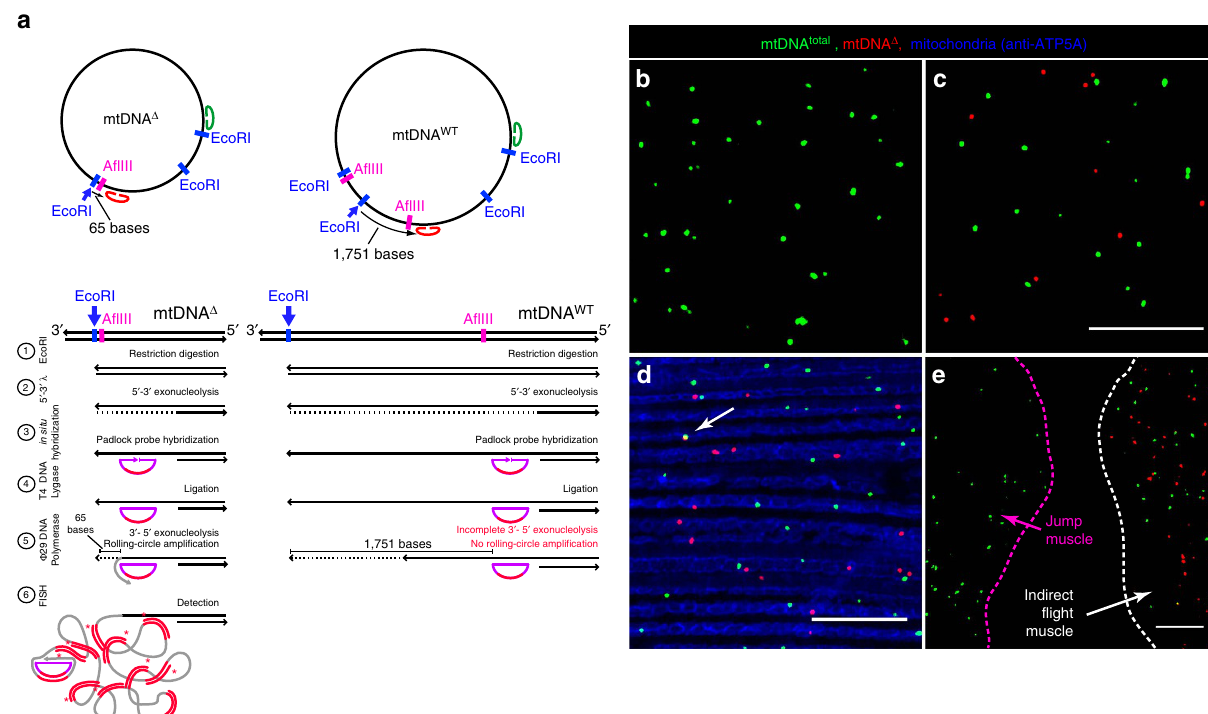
Figure 3 | Rolling circle-based quantification of mtDNA total and mtDNA D . ( a ) Strategy for visualizing mtDNA D and total mtDNA in situ , using padlock probes and target-primed rolling-circle amplification (tpRCA). ( b ) P{ pIFM-Gal4 }attP1 (wild type) IFMs reacted with probes specific for mtDNA D (red) and mtDNA total (green) contain only green dots. ( c – e ) IFMs from P{ pIFM-mitoAflIII, pIFM-mitoT4lig, pIFM-Gal4 }attP1 ( mitoAflIII ) flies contains red and green dots. ( d ) IFMs from mitoAflIII flies stained with anti-ATP5A (blue) show mitochondrial localization of red and green dots. Co-localization between fluorophore-tagged mtDNA D and mtDNA total was seen only rarely (white arrow in d ), reflecting the fact that tpRCA labels only a small fraction of nucleoids 42 . ( e ) Tissue from mitoAflIII flies containing IFM and the neighbouring jump muscle (Supplementary Fig. 1). Red and green dots are observed only in the IFMs, in which AflIII and T4 ligase are expressed. Scale bar, 10 m M ( c – e